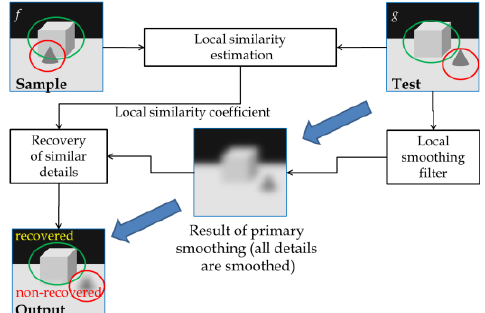
Figure 1. The scheme of comparative filtering based on guided local